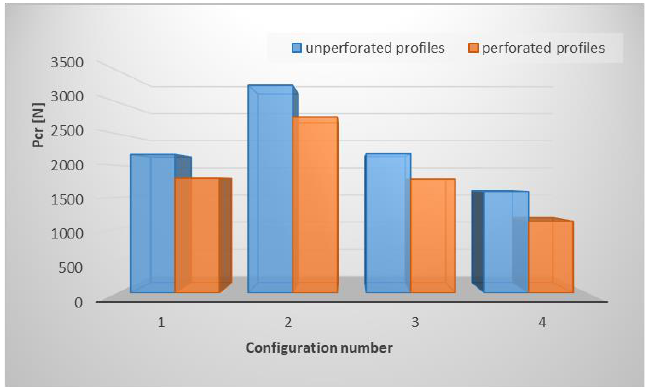
Figure 8. Effect of opening ratio and space ratio on critical buckling load for different hole shapes.